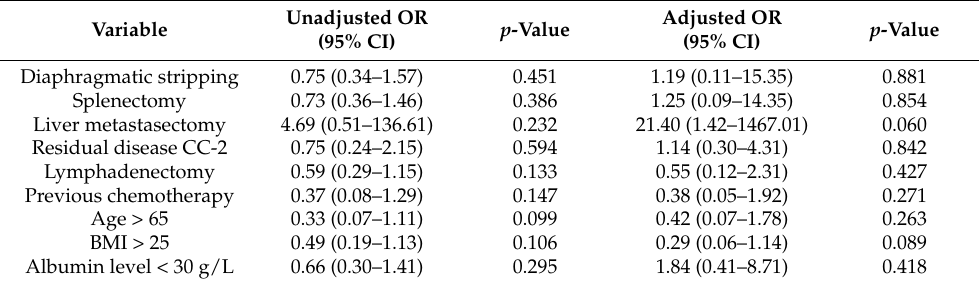
Table 1. Unadjusted and adjusted odds ratios (OS) for variables included in the logistical regression model for the occurrence of any adverse event following TC during cytoreductive treatment of OC. Unadjusted OR Adjusted OR p -Value p -Value Variable (95% CI) (95% CI) Diaphragmatic stripping 0.75